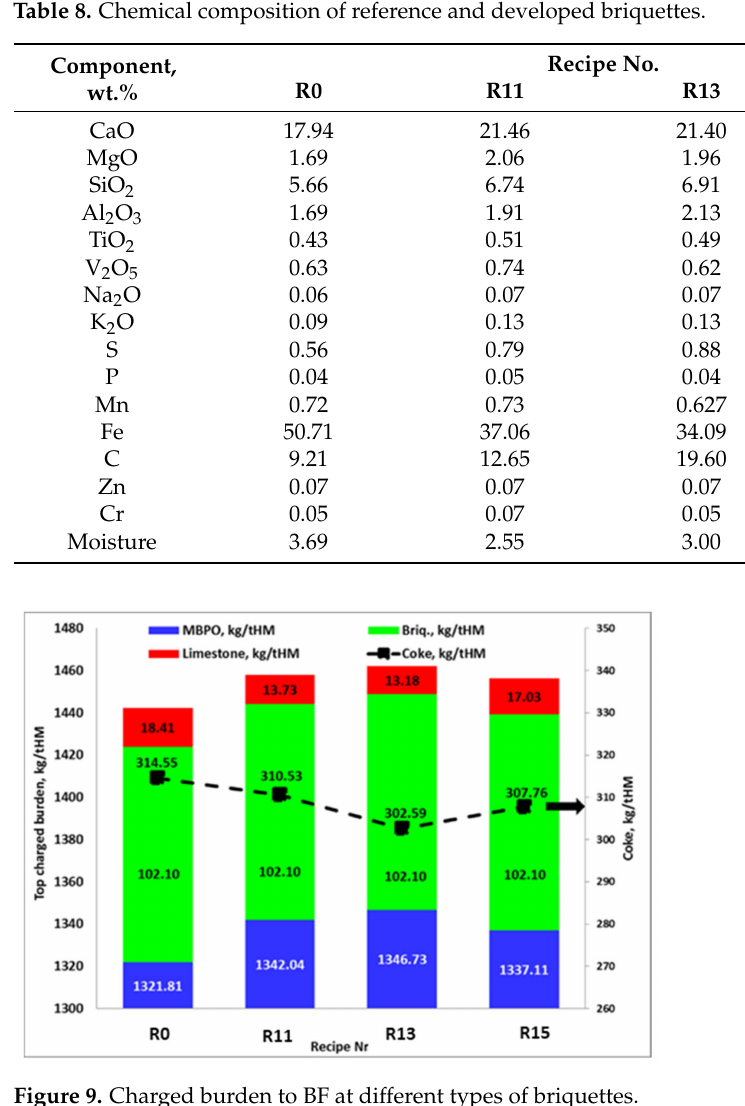
Figure 9. Charged burden to BF at different types of briquettes.